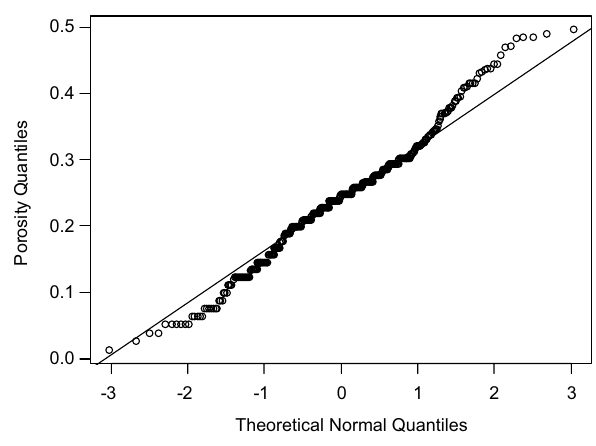
Fig. 6 Normal Quantile–quantile plot of all individual porosity val- ues—field-wide